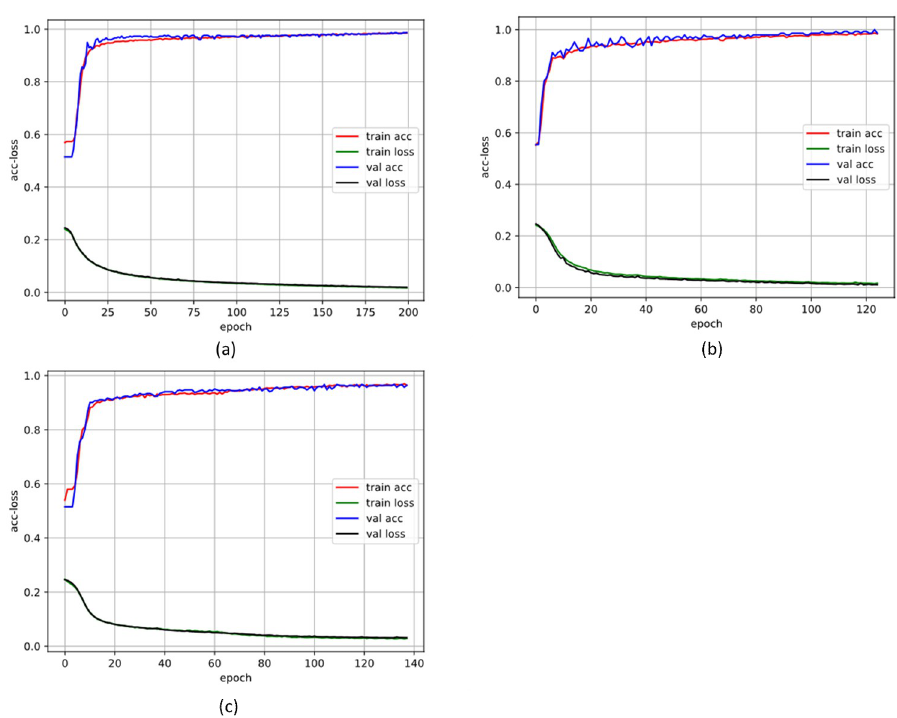
Figure 8. Training and validation loss function over the epochs in database 1 (DB1). ( a ) The 500 length segment; ( b ) the 1000 length segment; ( c ) the 2000 length segment.